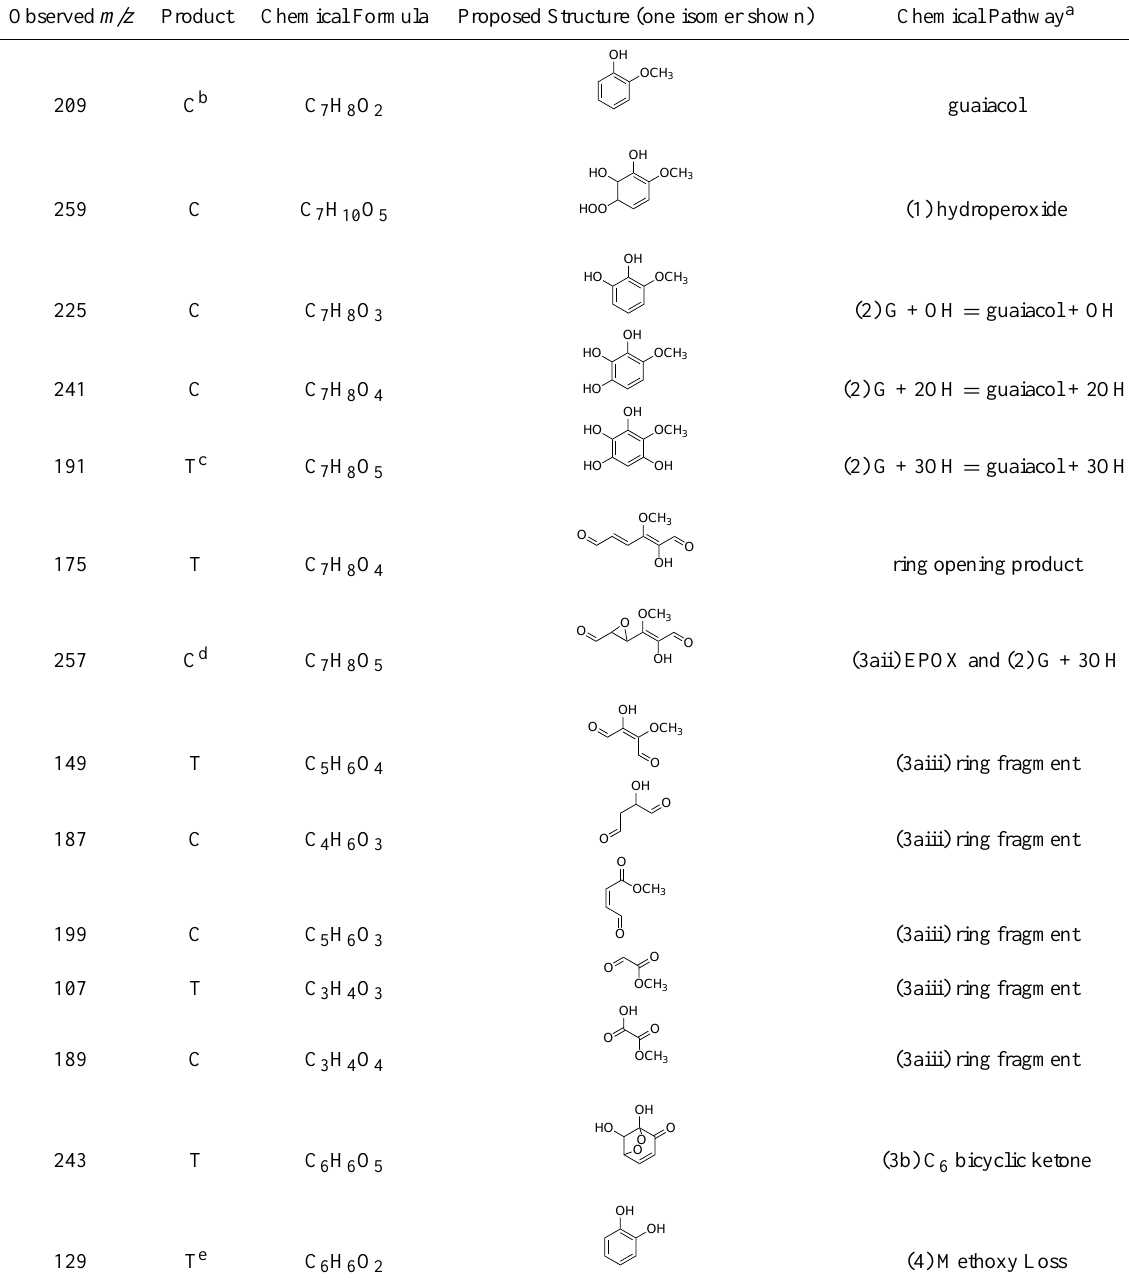
Table 4. Proposed structures for CIMS ions in the guaiacol low-NO x system. C and T indicate the cluster and transfer product, respectively. Observed